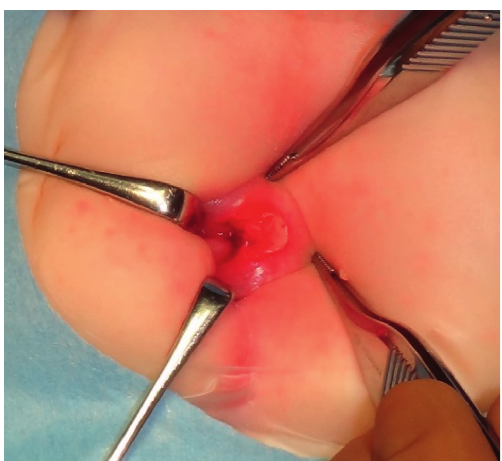
Figure 2: The perianal lesion was confirmed to extend into the anus.